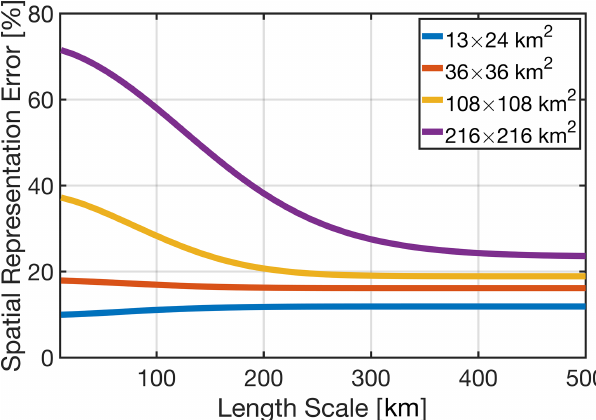
Figure 9. The spatial representation errors quantified based on the proposed method in this study. The error explains the spatial loss (or variance) due to the footprint of a hypothetical sensor at dif- ferent length scales. To put this error into perspective, a grid box with 216 × 216km 2 will naturally lose 65% of the spatial variance existing in the ratio at the scale of Los Angeles, which is roughly 50km wide. All of these numbers are in reference to the TROPOMI 3 × 3km 2